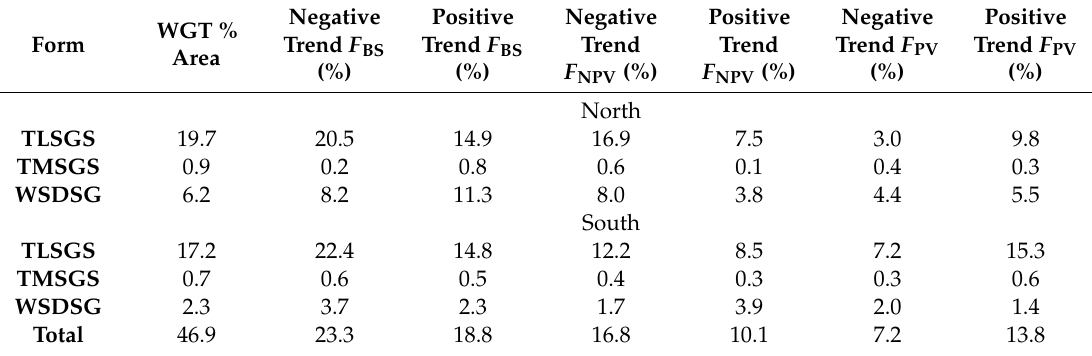
Table 3. Percentage of area of SWSG Divisions exhibiting significant trends in VFC > 0.1 or < − 0.1 % yr − 1 .